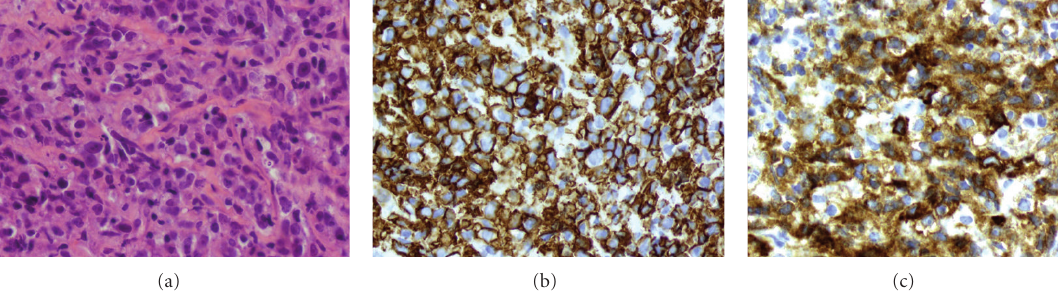
Figure 1: Primary mediastinal large B-cell lymphoma. (a) Hematoxylin and eosin (50X). Primary mediastinal B cells (PMBC) associated with delicate interstitial fibrosis. (b) PMBC immunoreactivity for B cell antigen on the membrane, CD20. (c) PMBC immunoreactivity for